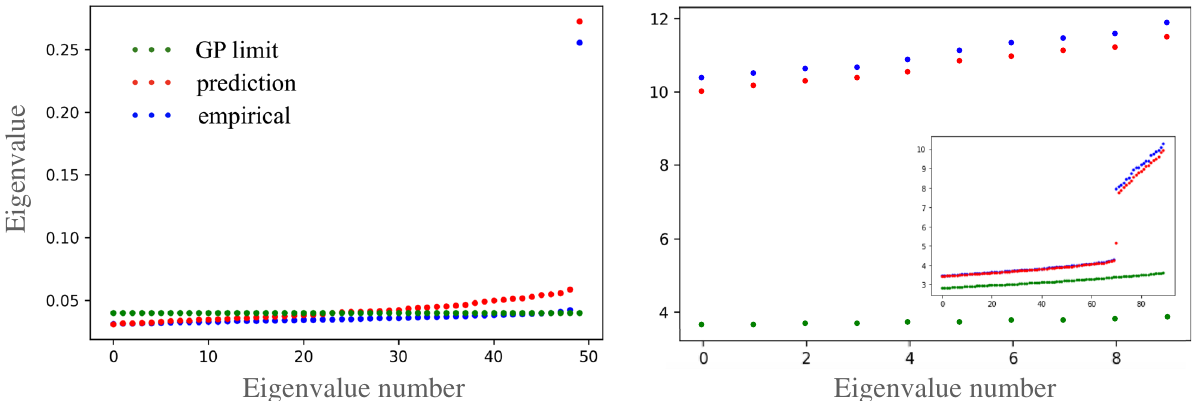
Fig. 5 | Theoretical, empirical, and GP spectrum of kernels for the 3-layer non- linear student-teacher CNN setting. Left: the leading 50 eigenvalues making up thespectrumof Σ fortheempirical Σ (blue),thepredicted Σ basedontheequations of state (red), and Σ at C → ∞ (green). Right: the leading 10 eigenvalues of the post- kernel of the hidden layer ( Q (2) ) again for the empirical, predicted, and GP post kernels. The inset shows the next 90 trailing eigenvalues and reveals a gap